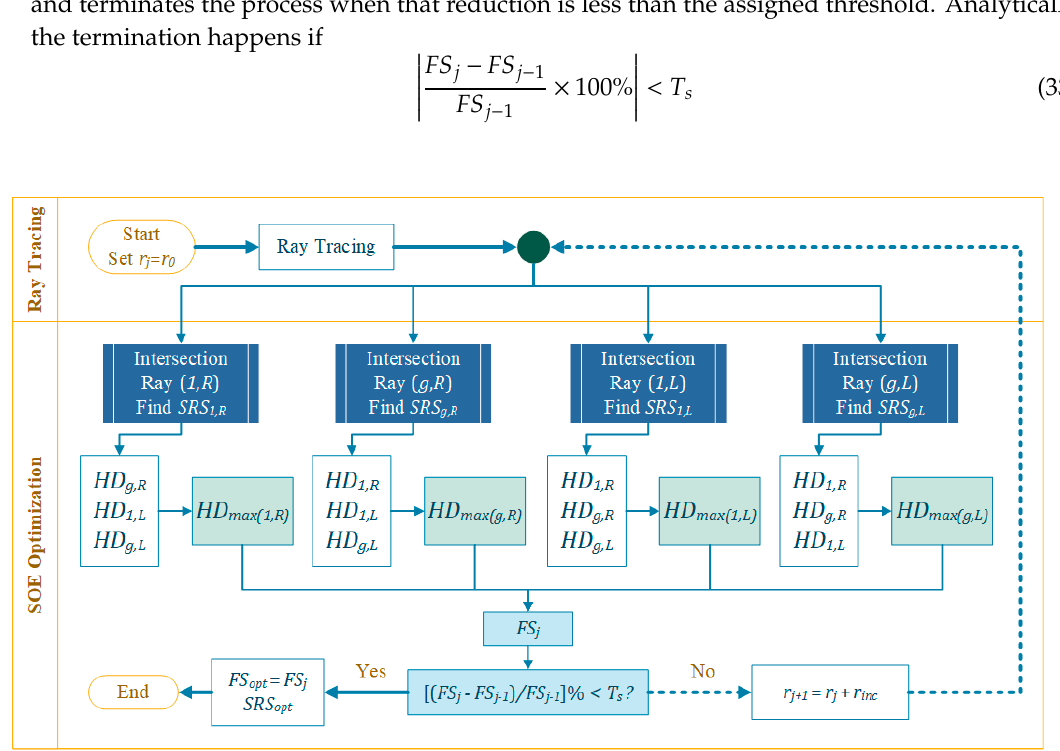
Figure 4. Schematic for the optimization algorithm of the SOE parameters.